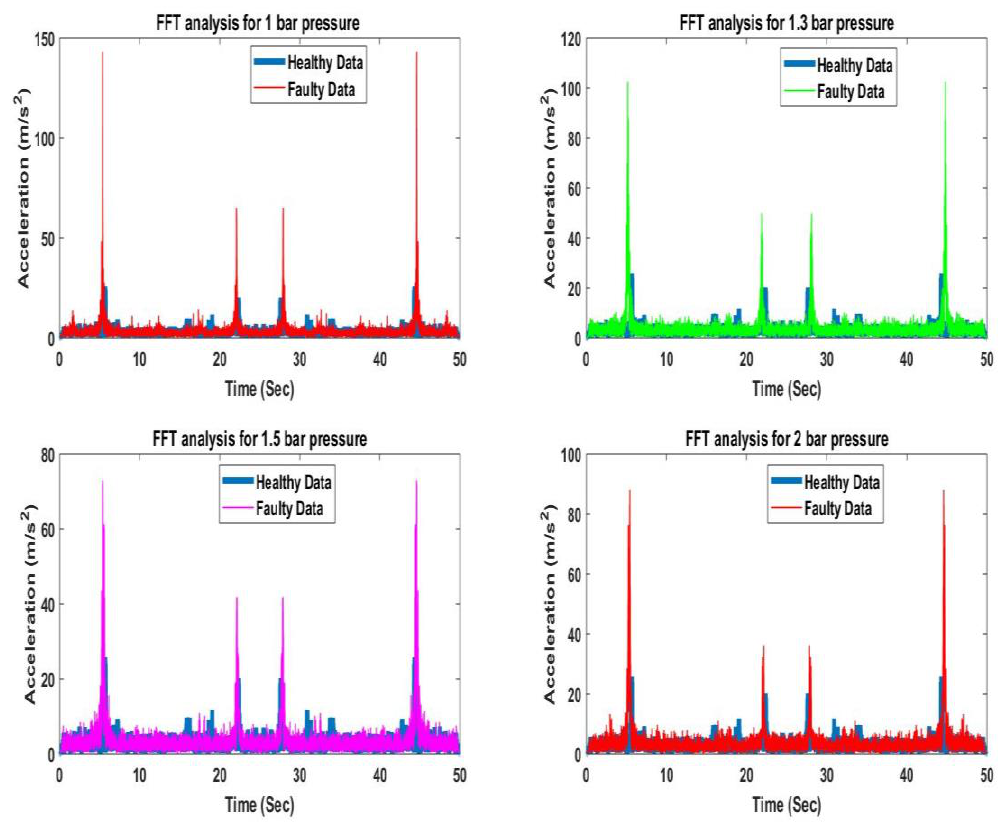
Figure 11. FFT analysis of healthy and faulty data of different acceleration concerning time.